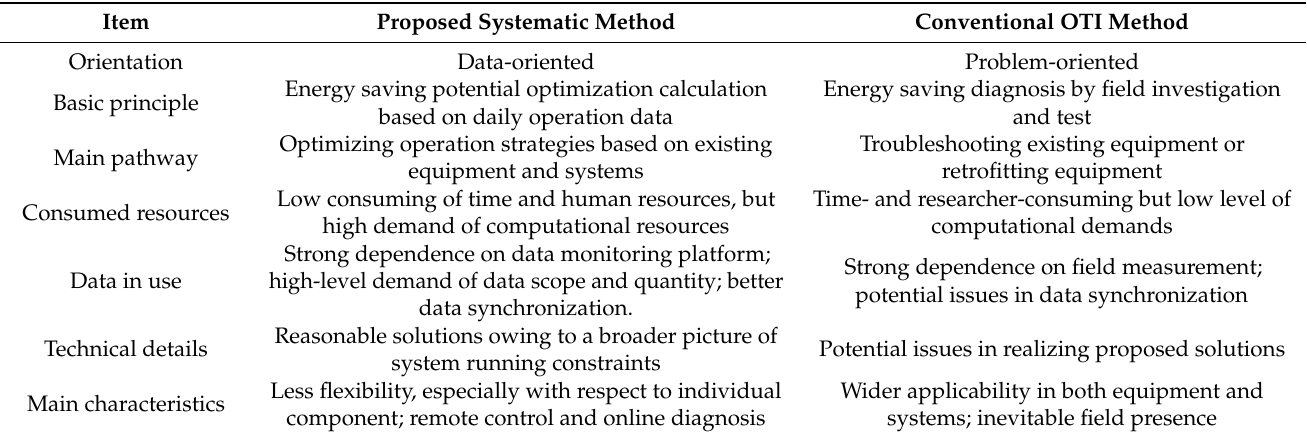
Table 4. Comparison between the proposed systematic method and conventional observation, test, and identification (OTI)